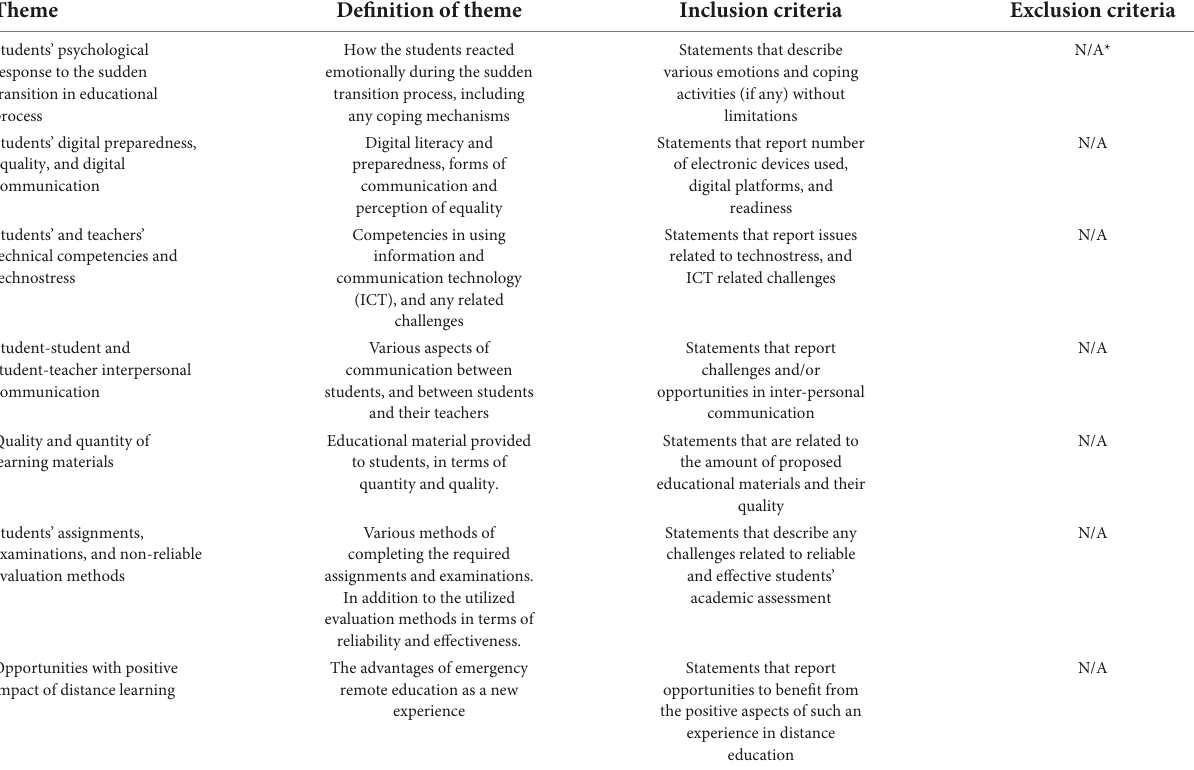
TABLE 2 Coding scheme with inclusion and exclusion